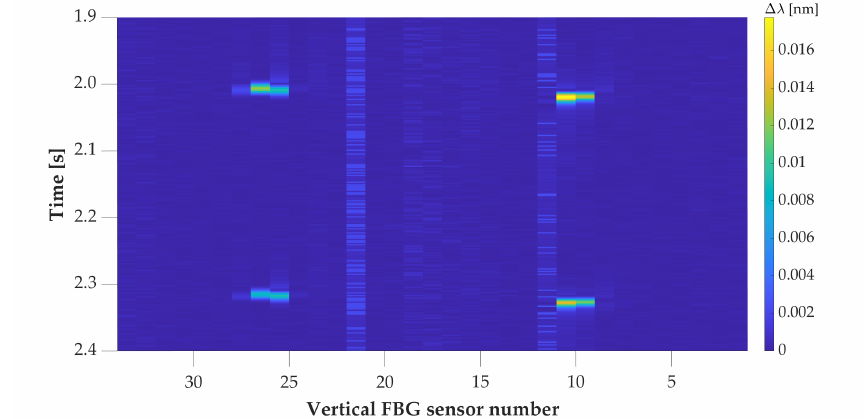
Figure 6. Record detail of the pressure map for a vehicle with an optimal line. The colormap represents the values of the wavelength change of the reflected optical spectrum by FBG in nm.